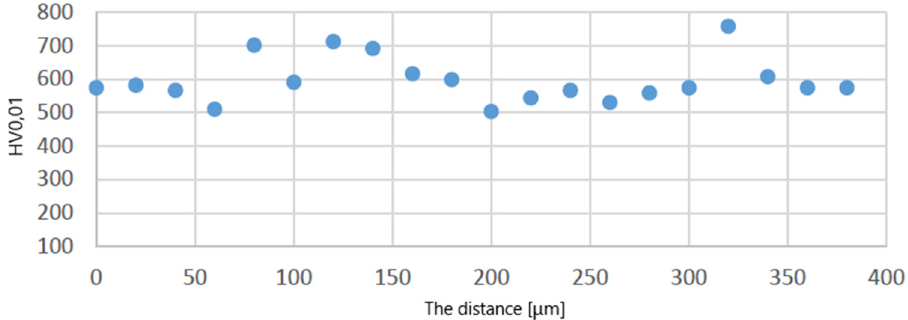
Figure 10. Distribution of microhardness on the leading edge for the protective coating made using the APS method.